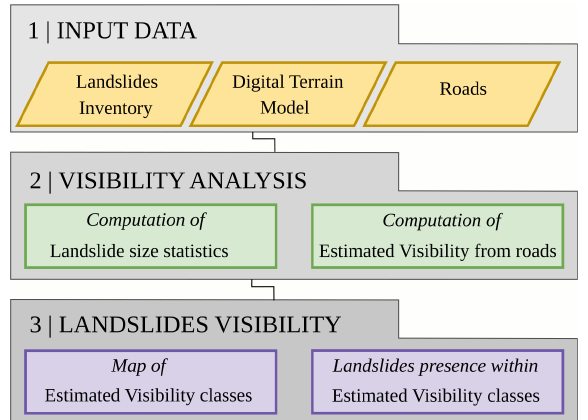
Figure 2. Conceptual chart illustrating the proposed GIS-based ap-